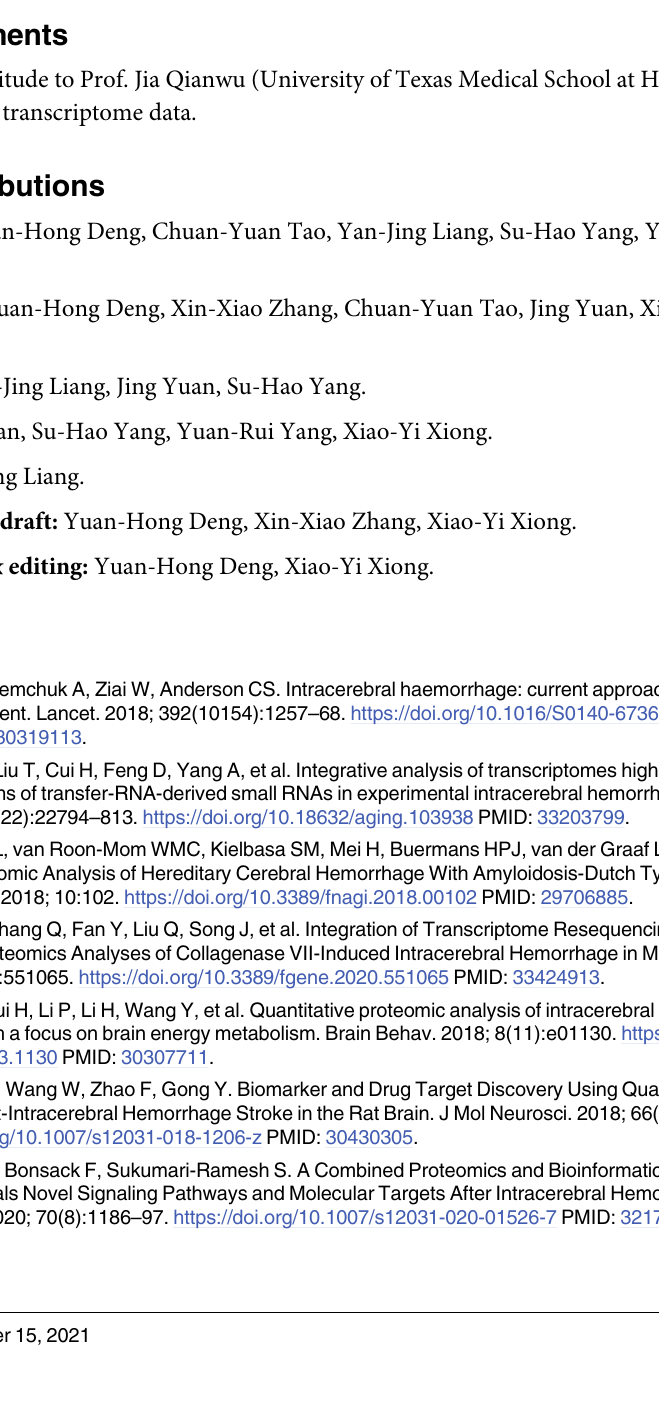
S2 Fig. MS spectrum of the representative succinylated sites. MS/MS spectra of